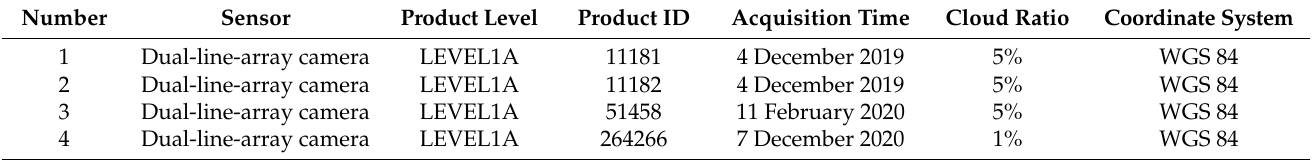
Table 1. Details of the GF-7 stereo images used in this study.